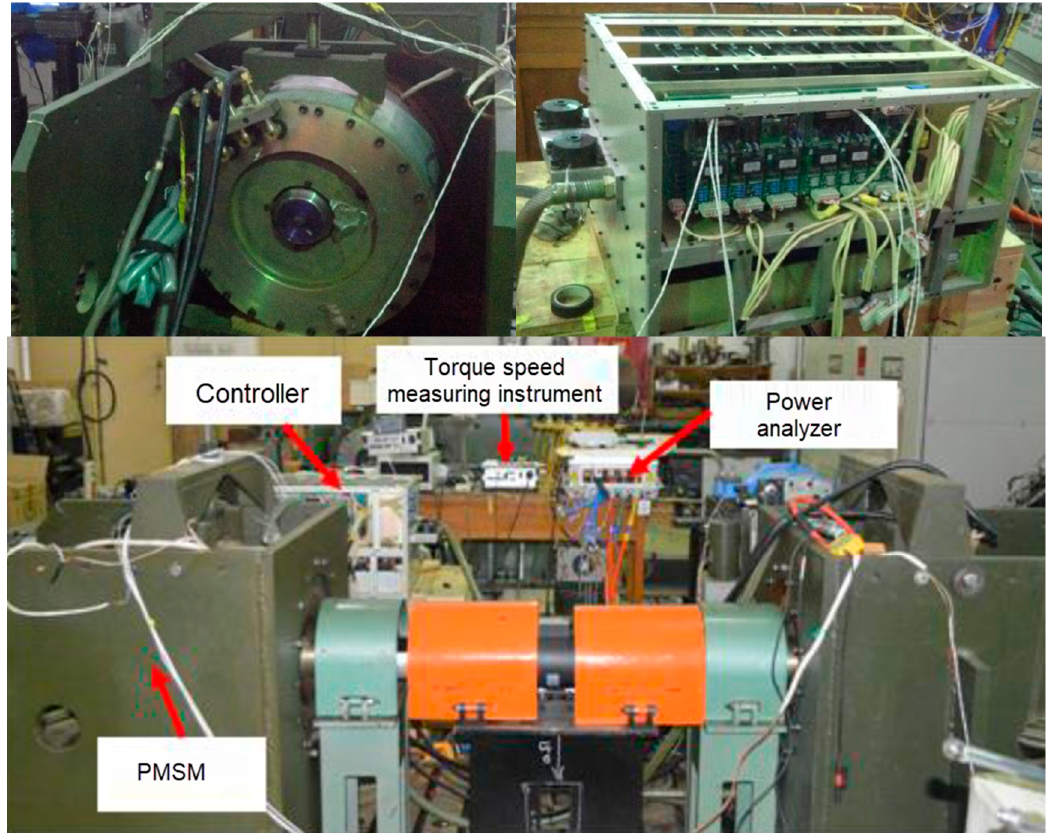
Figure 20. The motor prototype, controller and experimental bench.